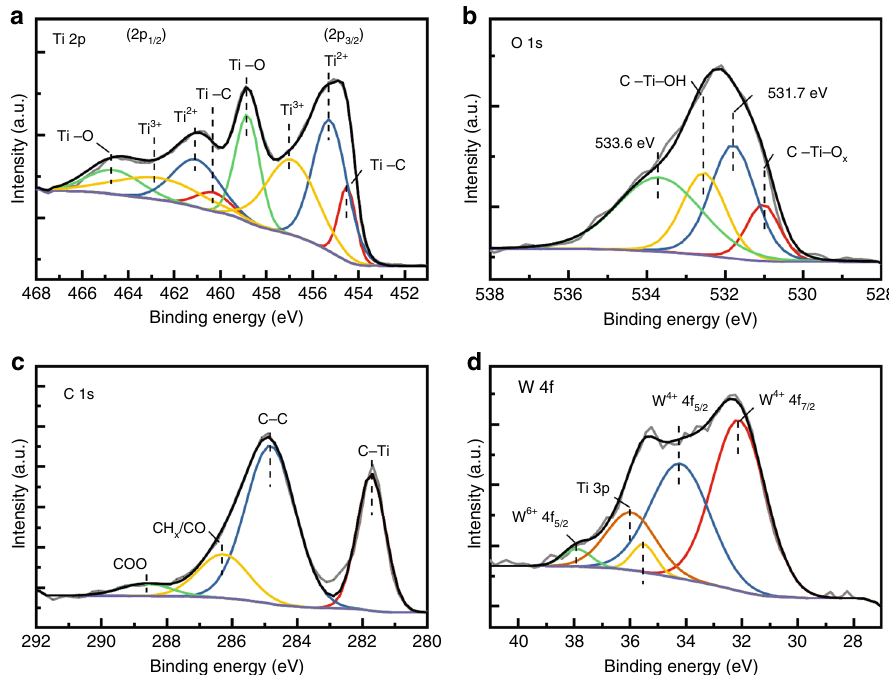
Fig. 3 Chemical composition of Ti 3 C 2 T x /WSe 2 nanohybrids. High-resolution XPS spectra of a Ti 2p, b O 1s, c C 1s, and d W 4f from Ti 3 C 2 T x /WSe 2 nanohybrids, showing chemical components and structures of Ti 3 C 2 T x /WSe 2 nanohybrids. Gas-sensing performance of WSe 2 decorated MXene sensors . The sensing performance of Ti 3 C 2 T x decorated with various amounts of WSe 2 (2 and 4 wt%) toward 40-ppm ethanol was fi rst examined using individual Ti 3 C 2 T x and WSe 2 sensors as references. A detailed account of the results is presented in